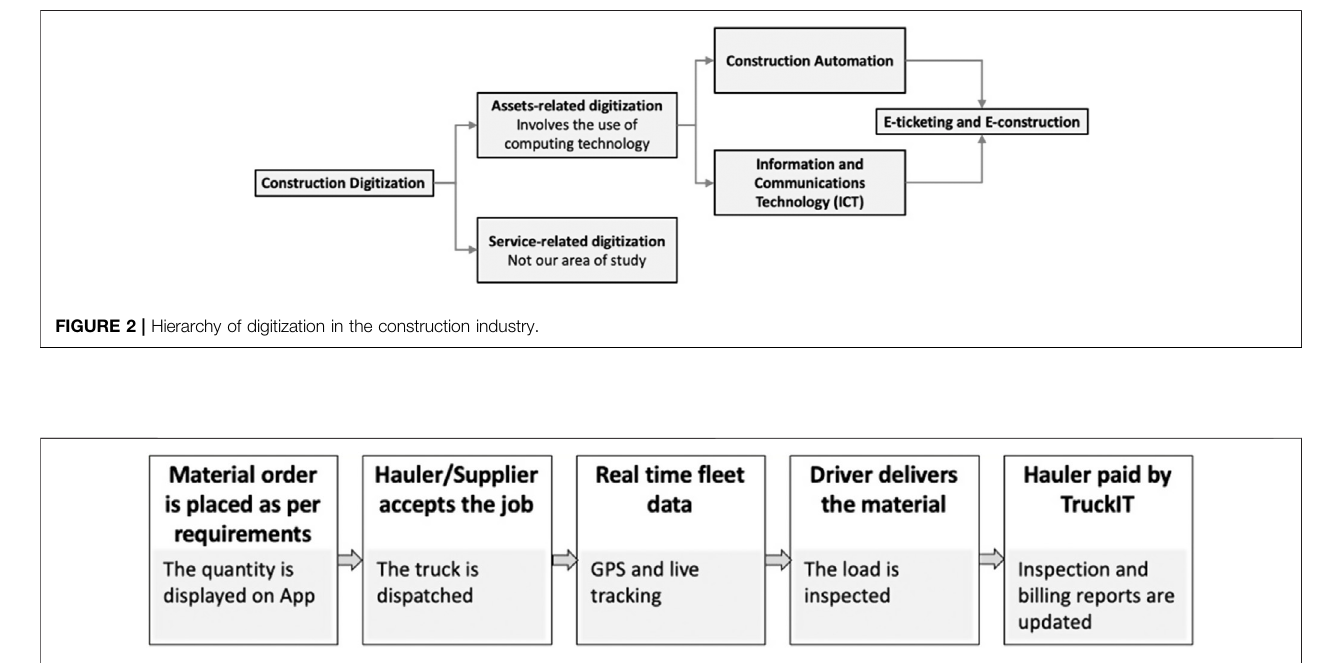
FIGURE 3 | Process of material delivery adopted by